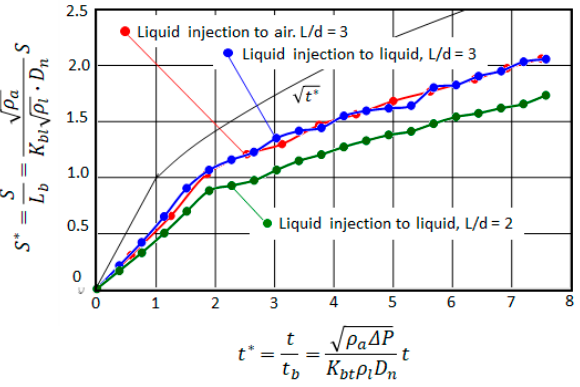
Figure 25. Spray tip penetrations normalized by old equations and coefficients.